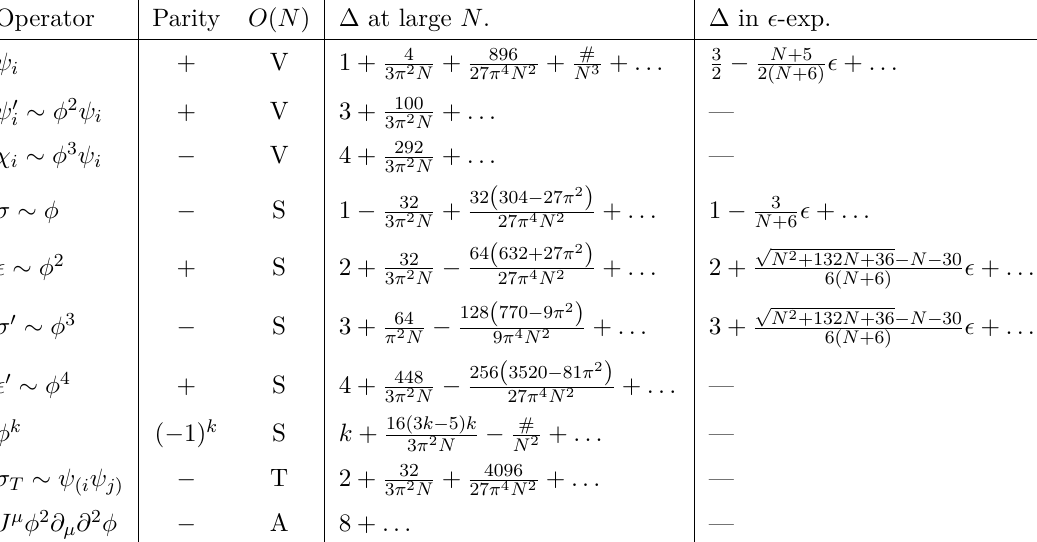
and ∆ are new and derived in appendix B. The numerators ψ 0 χ has a ψ has a negative correction (for φ k